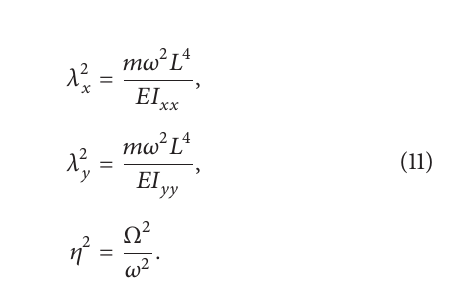
Figure 1: Degrees of freedom of a spinning beam segment.